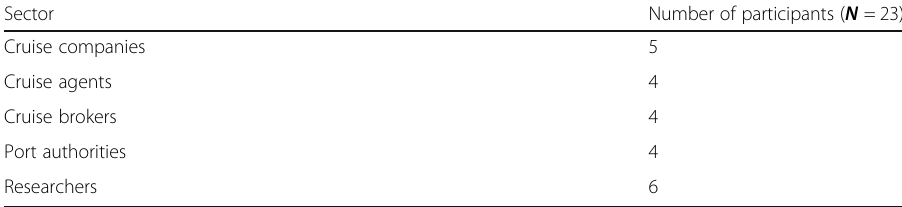
Table 4 Composition of the pool of experts